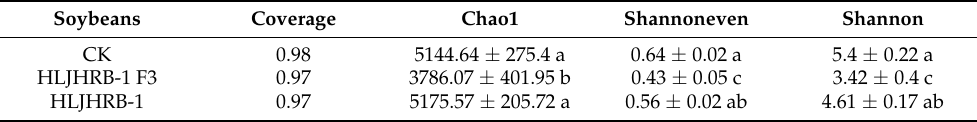
Table 2. Alpha diversity of rhizosphere soil of CK, HLJHRB-1 F3, and HLJHRB-1.